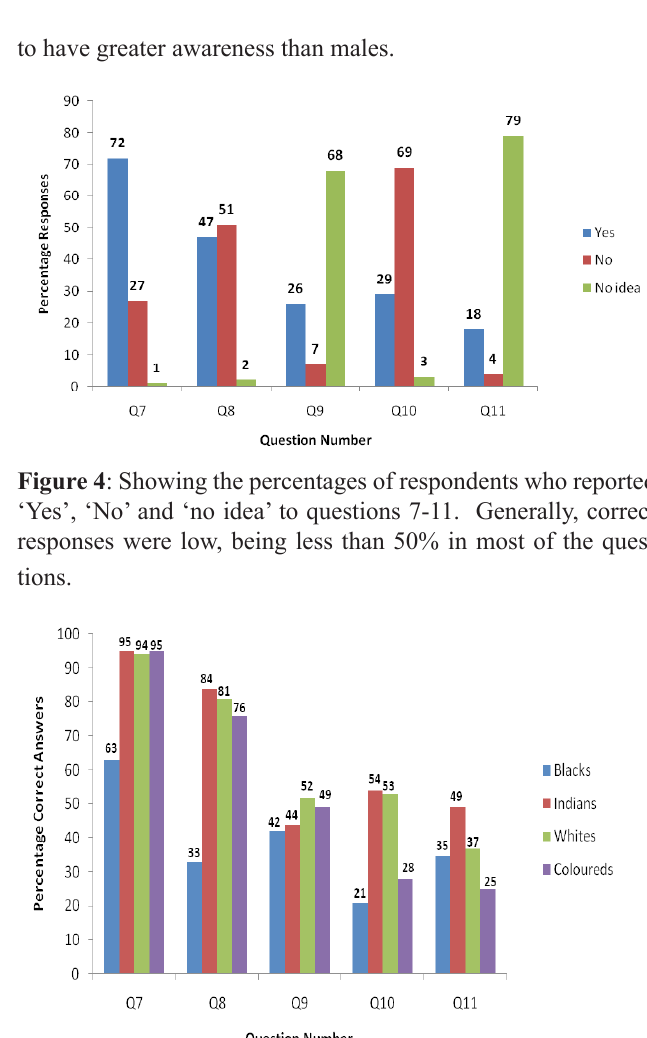
Figure 5. Showing the percentages of correct responses within each race for questions 7-11. The Indians and Whites appeared to have greater knowledge on these aspects. Correct responses were higher for having heard of UV and cataract (questions 7 and 8)